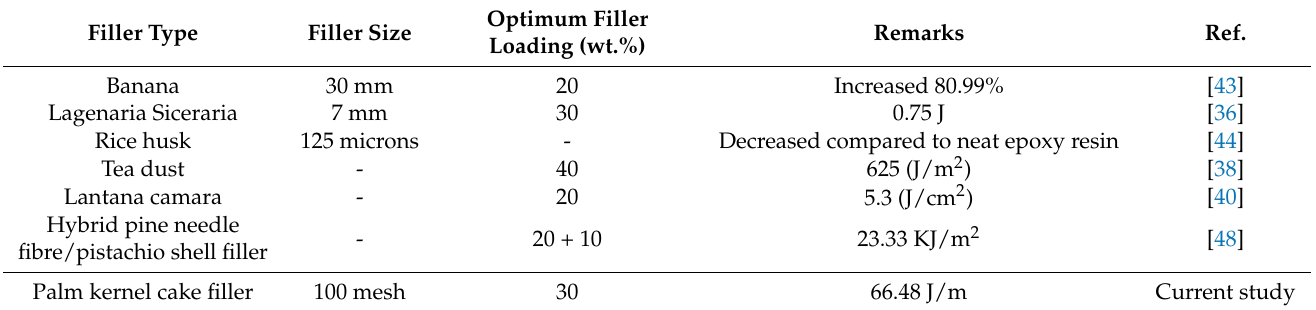
Table 6. Reported previous studies on Izod impact of filler-reinforced epoxy